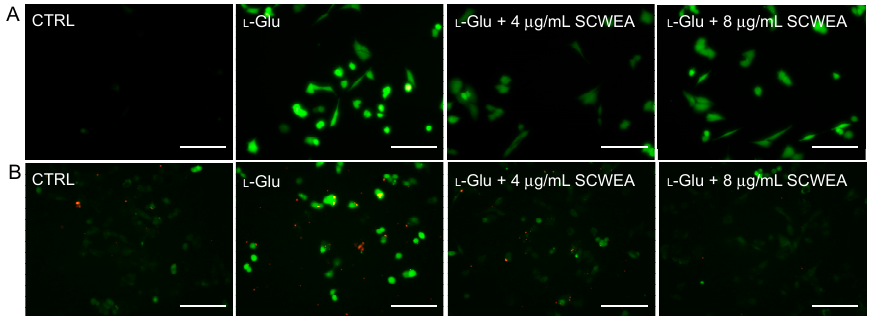
Figure 4. SCWEA suppressed Ca 2+ influx ( A ) and intracellular reactive oxygen species (ROS) accumulation ( B ) in L -Glu-exposed DPC12 cells (20×; Bar: 100 µm). Cells were pretreated with 4 and 8 µg/mL SCWEA for 3 h, followed by exposure to 25 mM L -Glu for another 12 h. The intracellular levels of Ca 2+ and ROS were detected by Fluo-4-AM and DCFH-DA staining, respectively. The experiments were repeated three times.